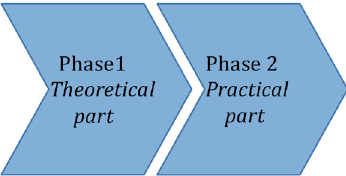
Fig. 1. The two development phases.